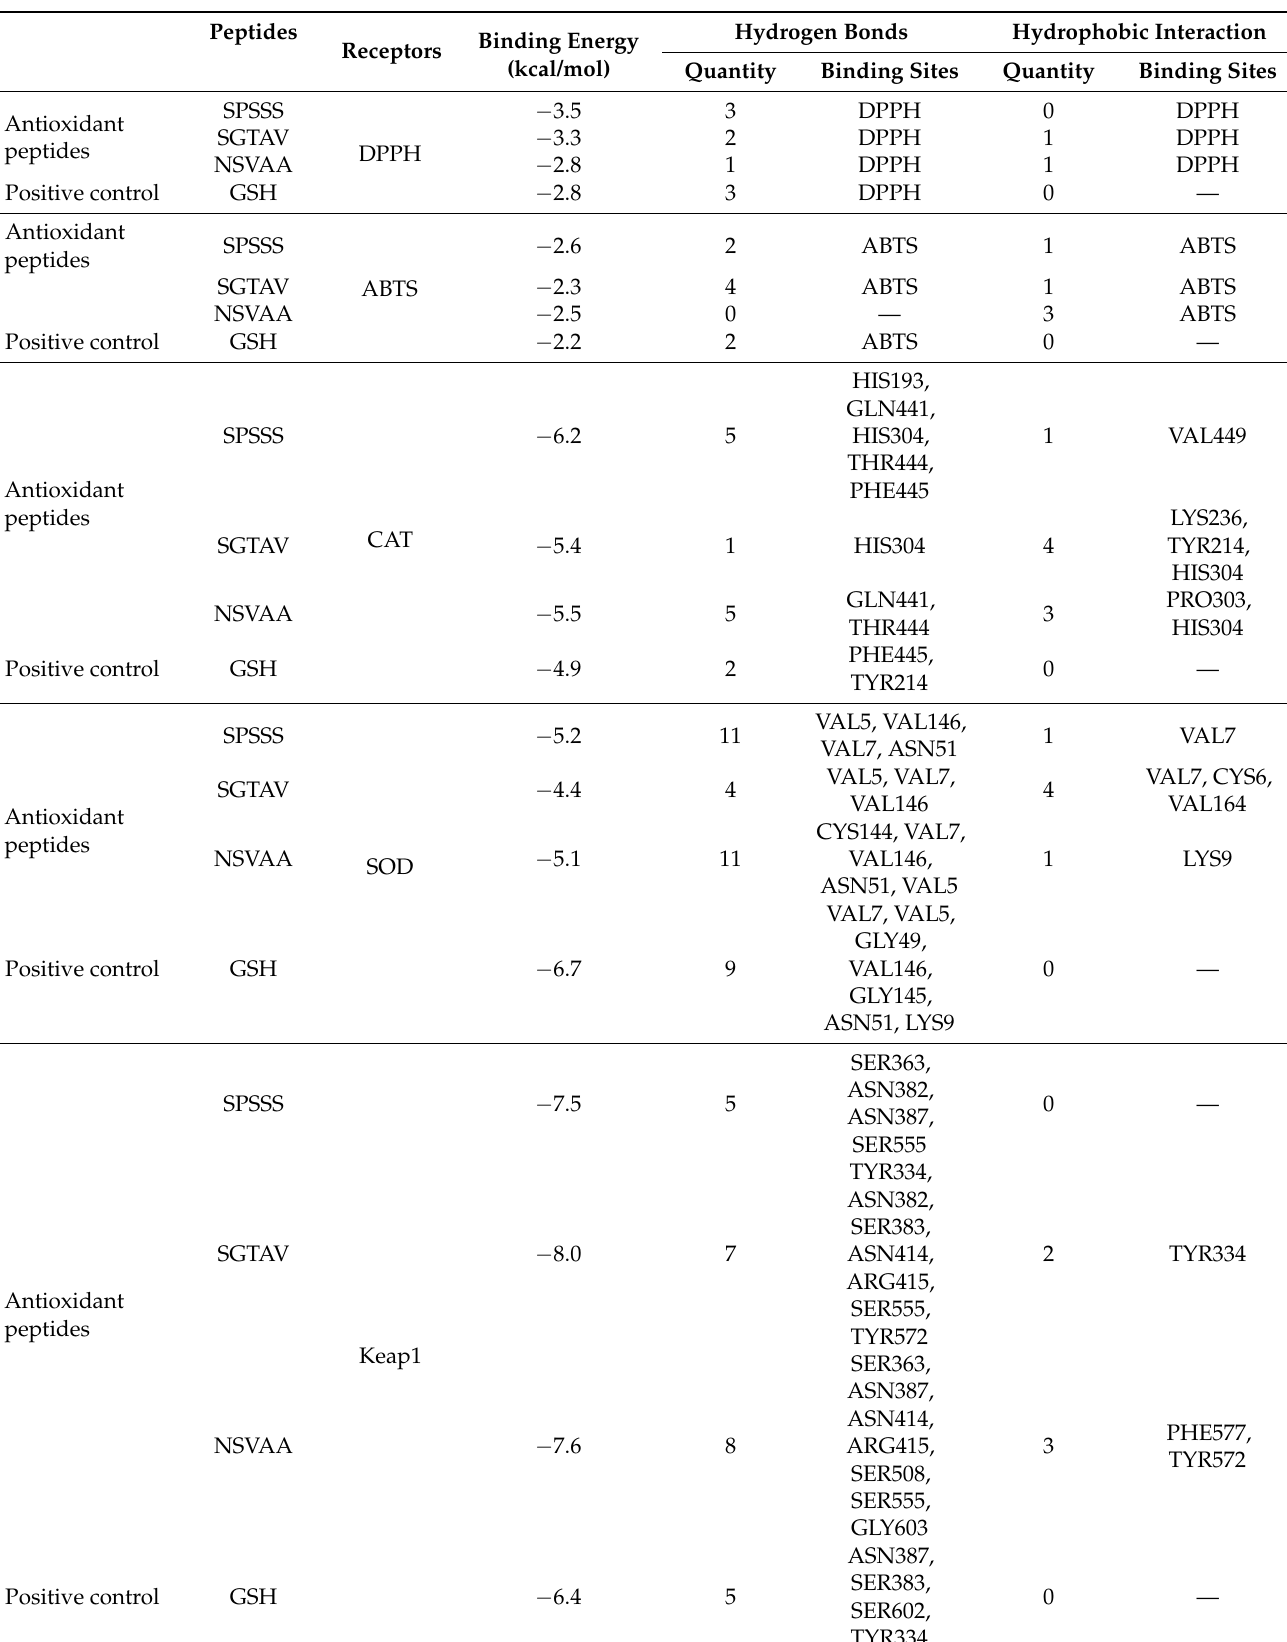
Table 3. Molecular docking results of antioxidant peptides with related